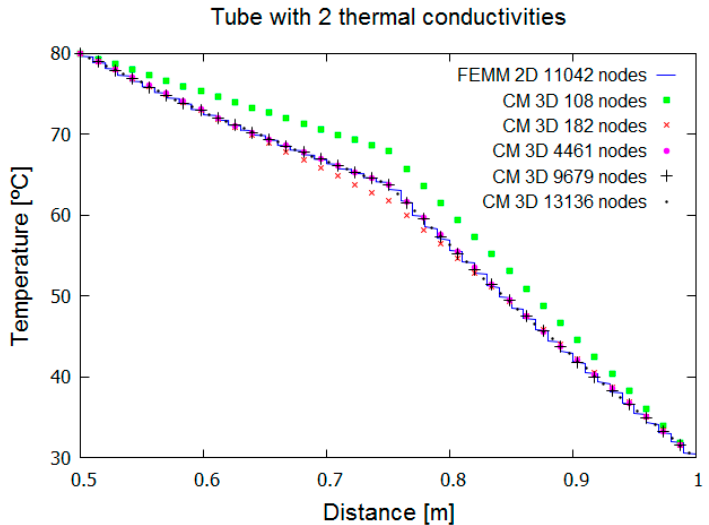
Figure 8. Temperatures in the tube with two thermal conductivities using [ M λ ] .